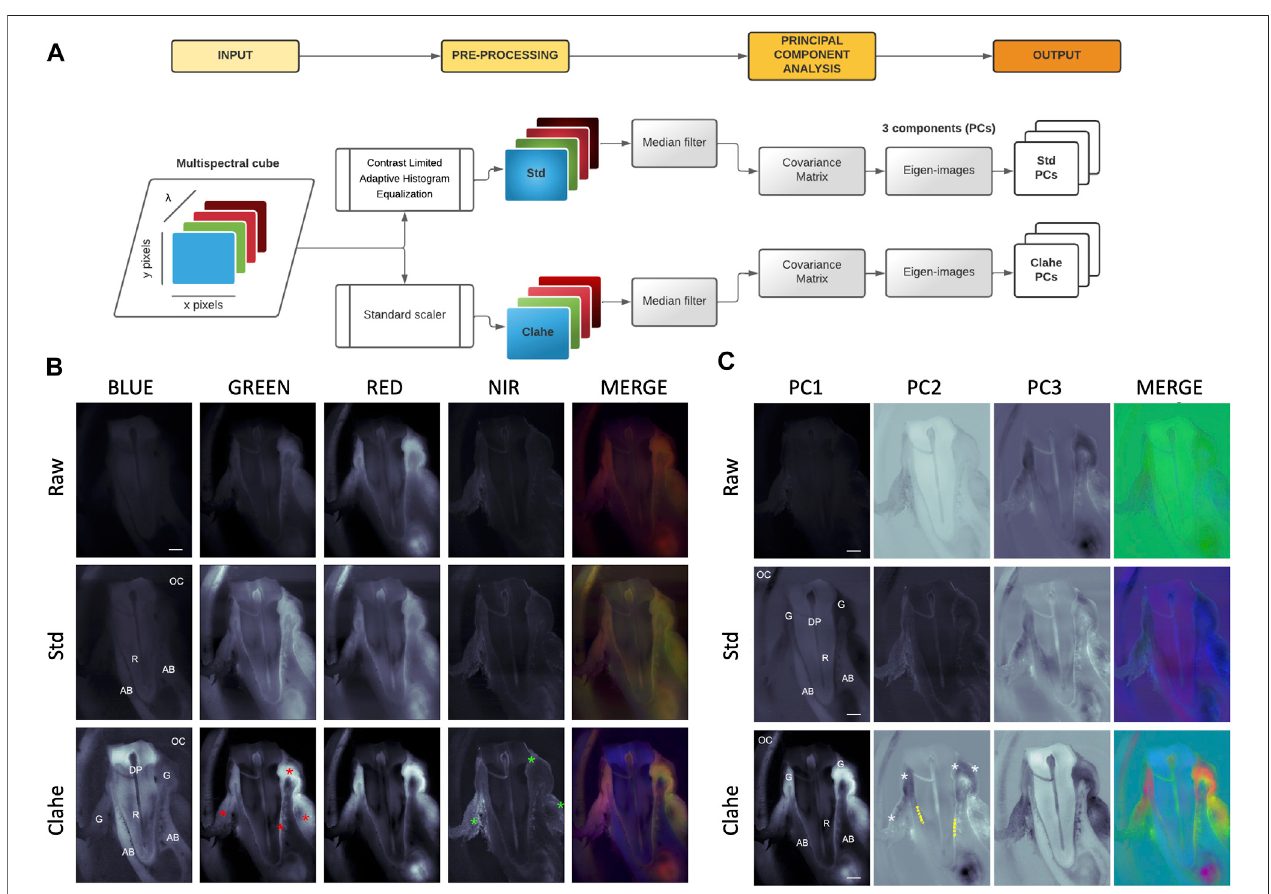
FIGURE 2 | Spectral Principal Component Analysis (sPCA) work fl ow. (A) — sPCA work fl ow involves preprocessing of fl uorescence acquisitions with standard scaler (Std) or Contrast Limited Adaptive Histogram Equalization (Clahe) including a median fi lter, followed by a Principal Component Analysis to derive 3 eigen-images. (B) — Std and Clahe preprocessing optimize the visualization of canine tooth root (R) and alveolar bone (AB) on a UV auto fl uorescence channel, and soft tissues on the other channels (red stars). Cell nuclei were particularly revealed by TO-PRO3 labeling in the NIR channel (green stars). OC: Oral Cavity. G: gingiva. DP: dental pulp. (C) — Topthreeeigenimagesderivedfromprincipalcomponentanalysis.Altogether,eigen-imagesfromStdandClahegreatlyoptimizedhard[toothroot(R)andalveolar bone (AB)] and soft tissue discrimination [epithelia (*), gingival stroma G, periodontal ligament (PDL, dashed lines) and dental pulp (DP)]. OC: Oral cavity. Scale bar: 2000